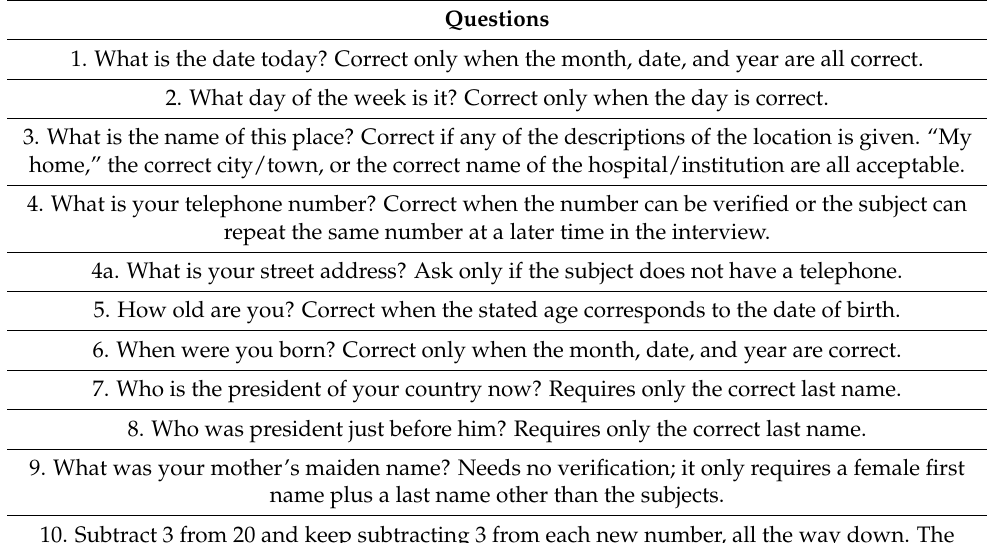
Table 2. Cognitive function assessment using Pfeiffer’s Short Portable Mental Status Questionnaire (number of errors)